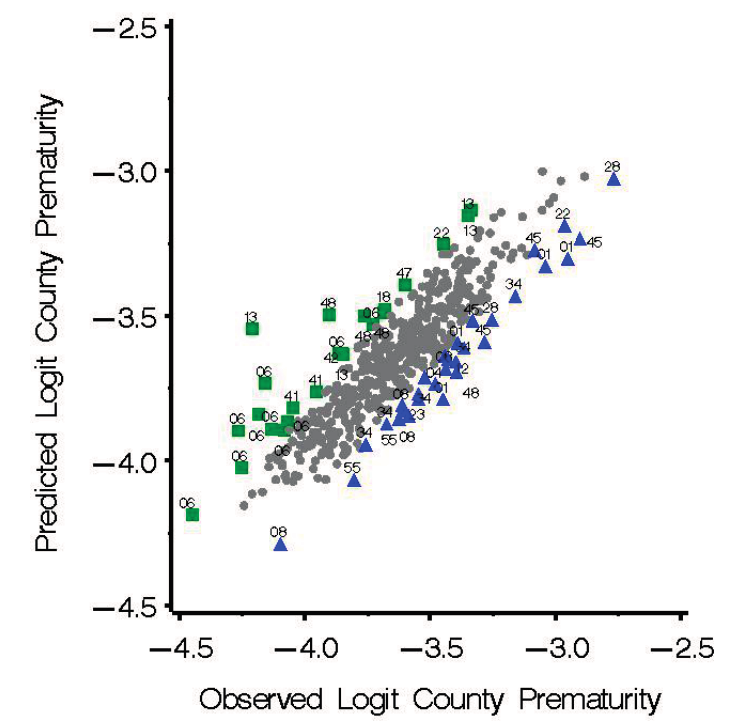
Figure 4. Observed logit of county prematurity percentage versus predicted (N = 512) in the overpredicted group (studentized residuals < − 1.5), the underpredicted group (studentized residuals >1.5) and the intermediate group (studentized residuals − 1.5 to